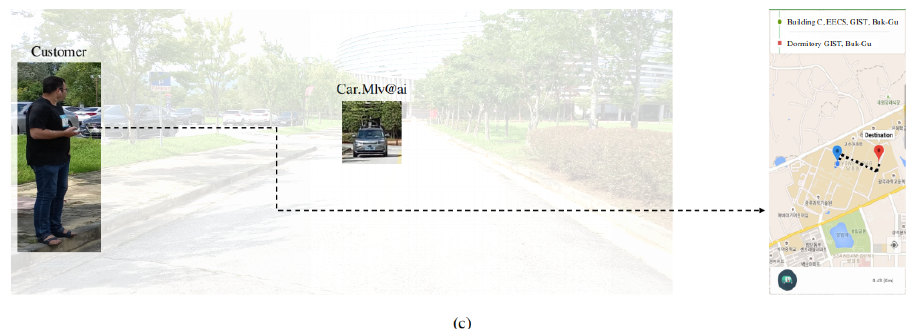
Figure 25. The visualization results of an autonomous vehicle approaching to pick up the customer. ( a ) The 3D map of the environment showing the ego vehicle and customer’s position. ( b ) The view of the customer from the autonomous vehicle front-facing camera. ( c ) illustrate the environment and also showing the app which customer is using to request for autonomous taxi service (Best viewed in color).